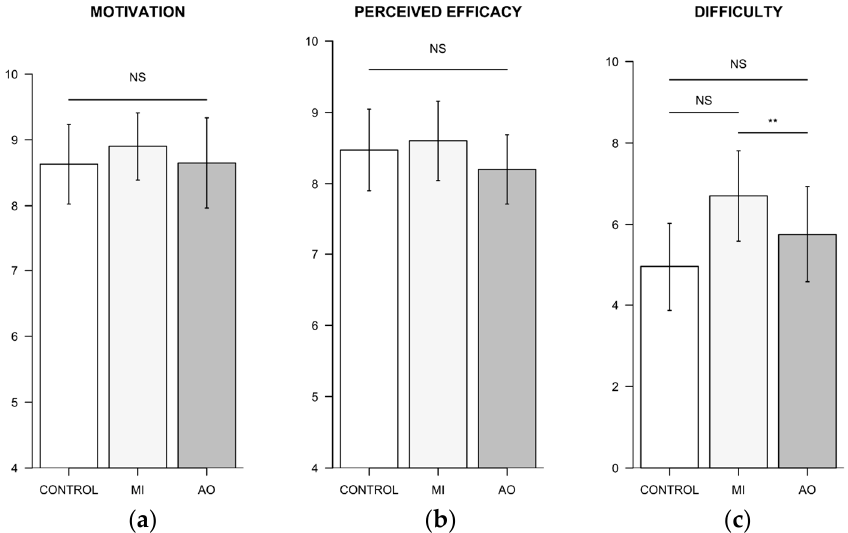
Figure 4. Bar plots obtained from participants’ self-report scores on the 10-points Likert scale. ( a ) Perceived motivation across experimental conditions; ( b ) Perceived efficacy across experimental conditions; ( c ) Perceived difficulty across experimental conditions. Error bars represent 95% confidence intervals. NS: Not statistically significant. MI: motor imagery. AO: action observation. ** p < 0.01.